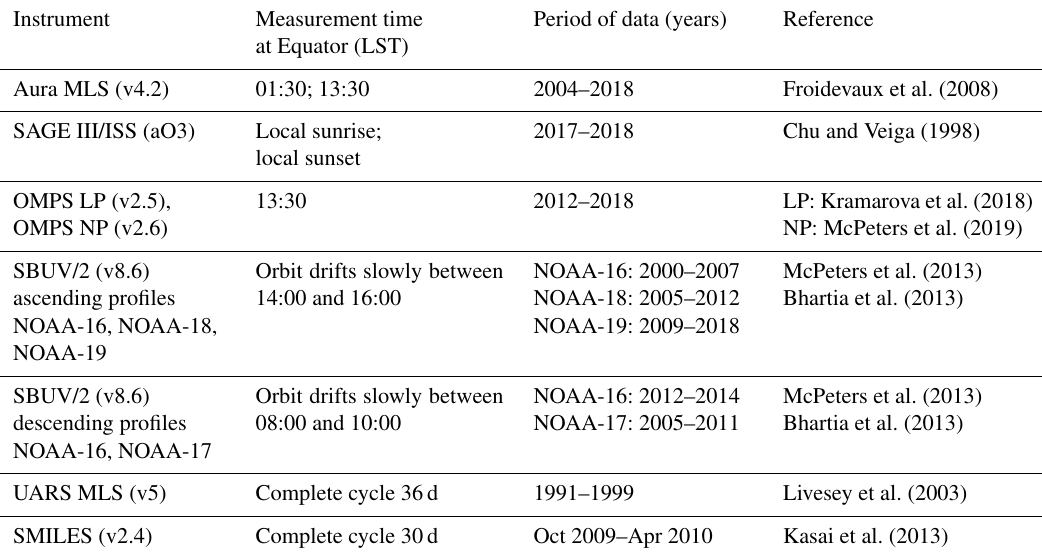
Table 1. Ozone observations and corresponding measurement